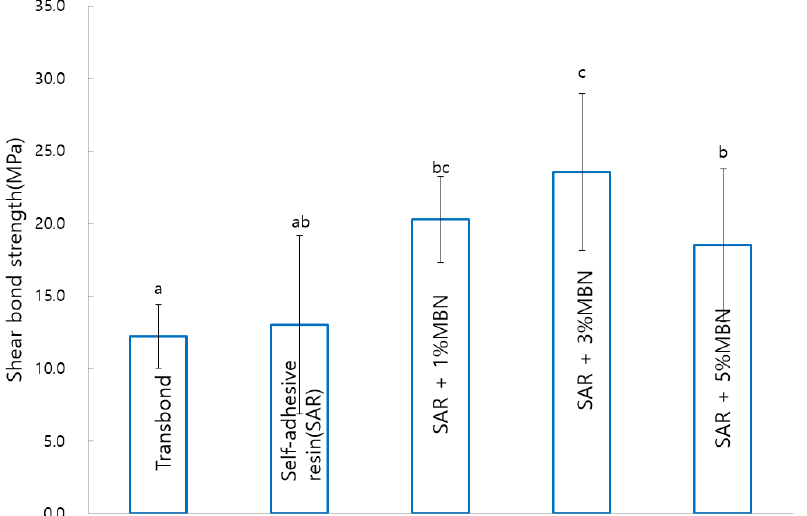
Figure 5. Comparison of shear bond strength (SBS) between the commercial control (Transbond XT), control (SAR), and MBN-treated SAR groups. Labels with the same letters indicate no statistically significant differences between groups. One-way ANOVA was performed ( n = 20).